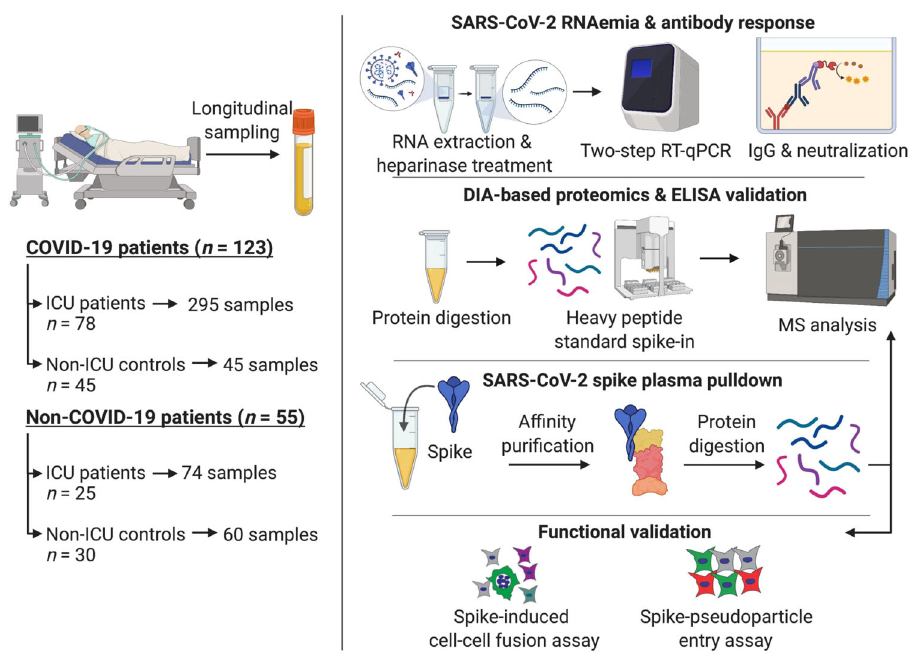
Fig. 1 Schematic of study design. Plasma and serum samples were obtained from multiple patient cohorts across two UK-based university hospitals, including 123 COVID-19 patients: 78 SARS-CoV-2 positive patients in ICU were sampled at multiple time points over a 2-week period and compared to hospitalized non-ICU SARS-CoV-2 positive patients ( n = 45). We used non-COVID-19 ICU patients ( n = 25) and patients before undergoing elective cardiac surgery ( n = 30) as controls. Patient samples were assessed for SARS-CoV-2 RNAemia, antibody responses, and protein changes in the circulation by data-independent acquisition (DIA) mass spectrometry (MS) analysis. Plasma protein interactions with SARS-CoV-2 spike glycoprotein were determined using a pulldown assay followed by data-dependent acquisition (DDA) MS analysis. Functional effects of LGALS3BP were assessed in two assays: SARS-CoV-2 spike-mediated cell-cell fusion (syncytia formation) and cell entry through SARS-CoV-2 spike pseudoparticle